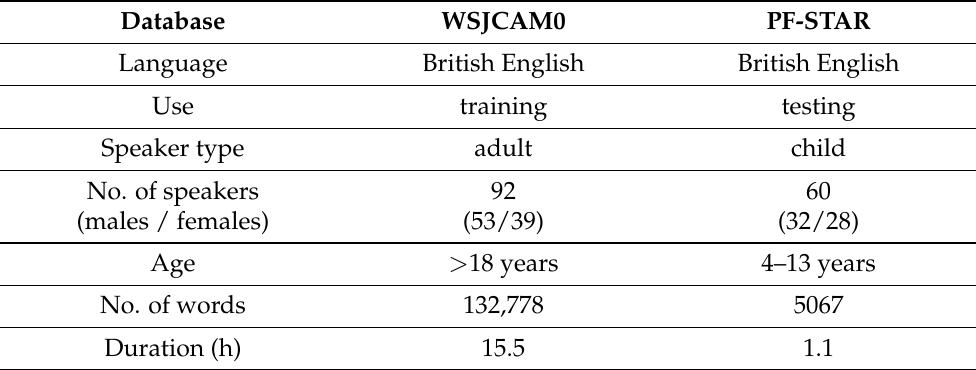
Table 2. Information on the two speech databases used in the current